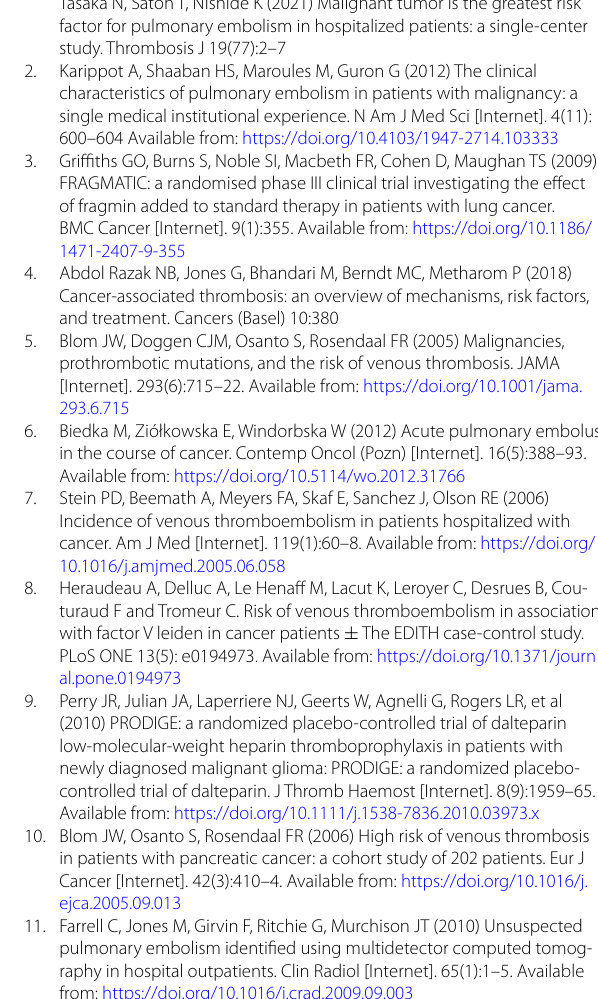
Total cases (540)